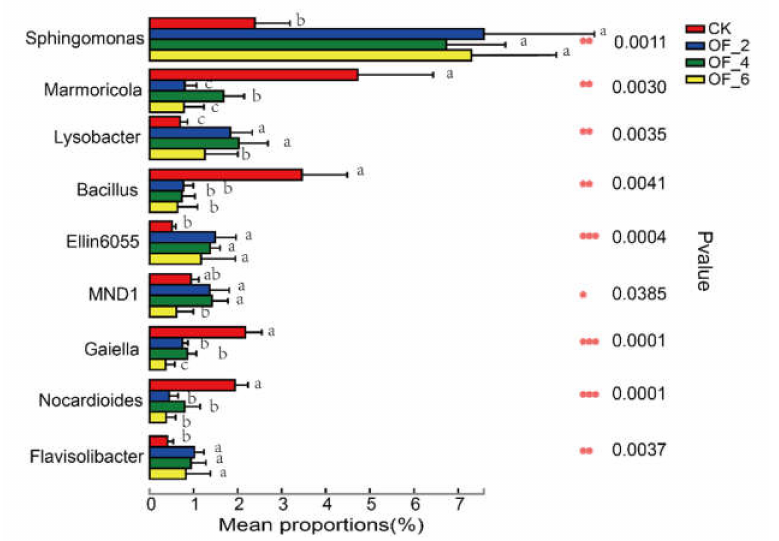
Figure 7. Bacteria with significant differences between different treated soil at the filling stage (genus